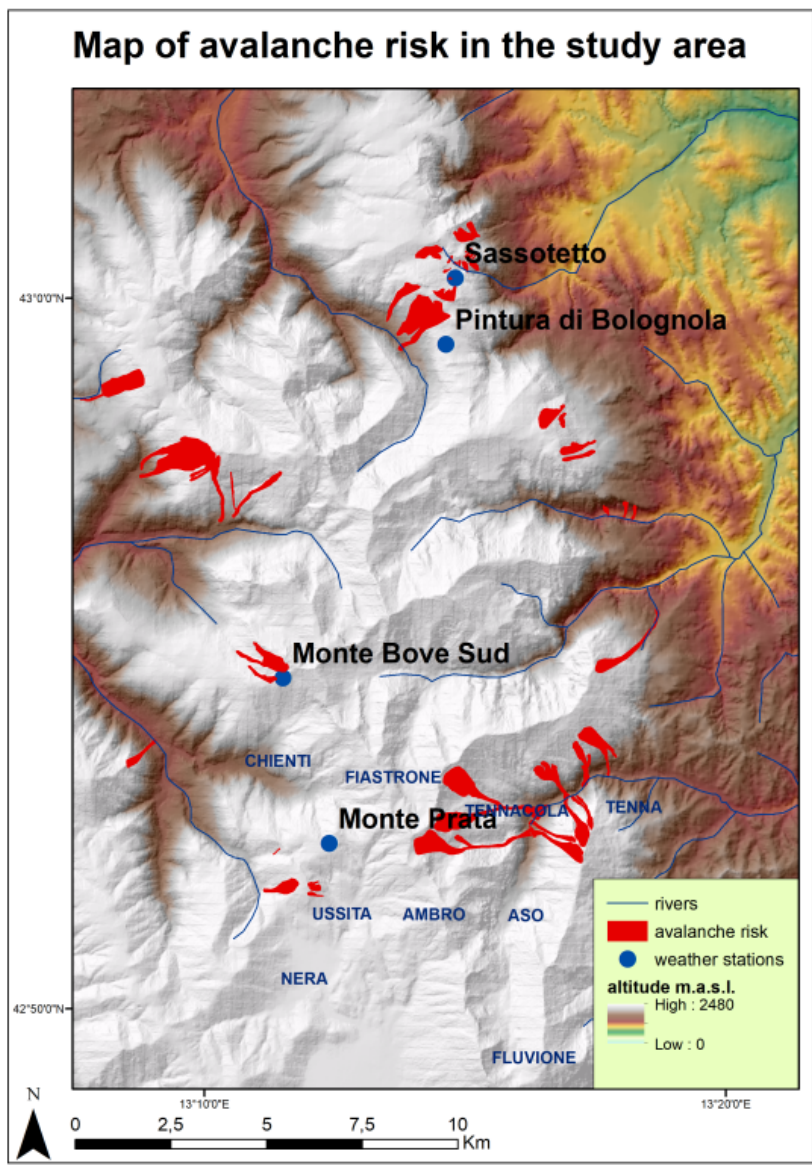
Figure 2. Avalanche risk map for the areas near the weather stations under investigation, risk areas outlined by the civil protection service of the Marche